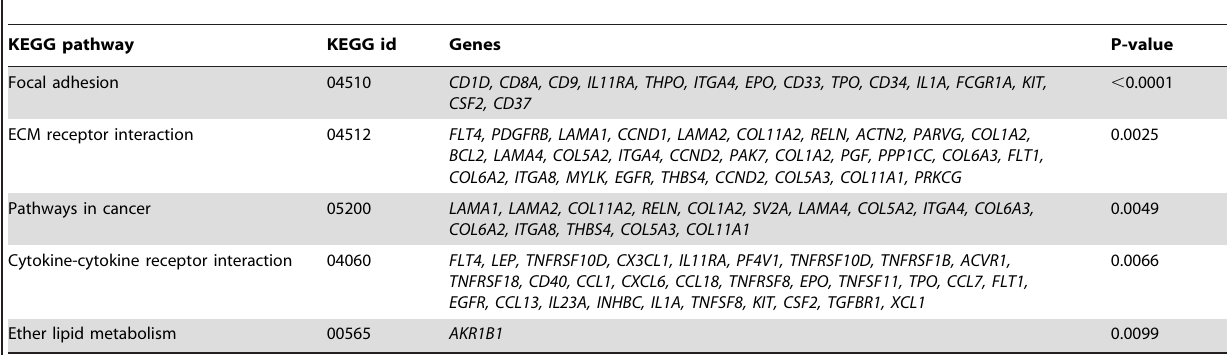
Table 2. Biological function of genes differentially methylated between normal breast tissues and breast tumors.